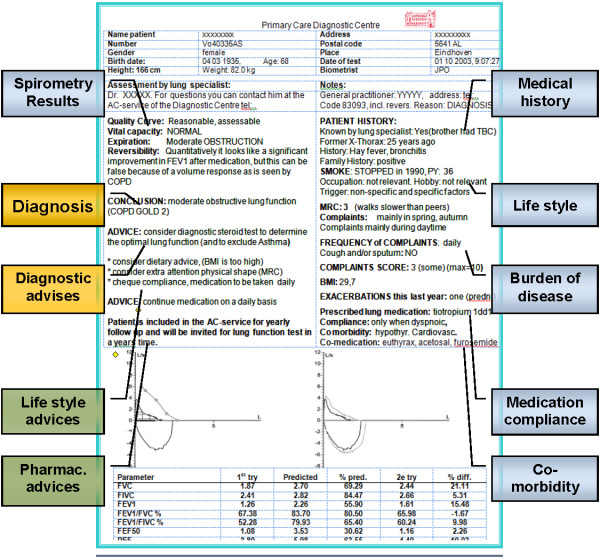
Chapters of information given in the Report of theAC-service.